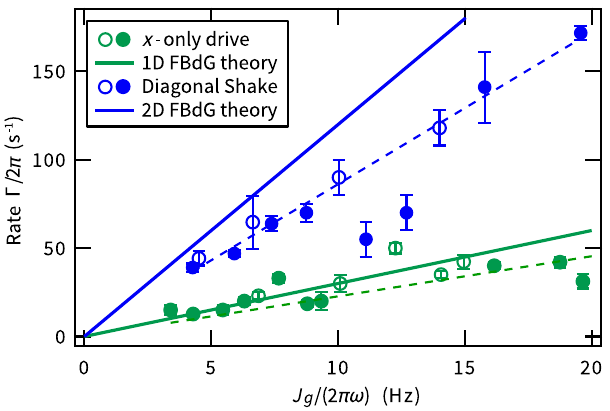
Jg= ω Þ : Measured decay rates for K 0 ¼ 2 . 1 , ω ¼ FIG. 2. Γ cf ð 2 π × 4 kHz (filled circles), and ω ¼ 2 π × 2 . 5 kHz (empty circles) and various lattice depths, compared to the FBdG theory. The horizontal axis is Jg= ð 2 × ω Þ , since the FBdG theory predicts the mode growth rate to be linear in J , g , and 1 = ω , as derived in the Appendix E. The dashed lines are linear fits to the